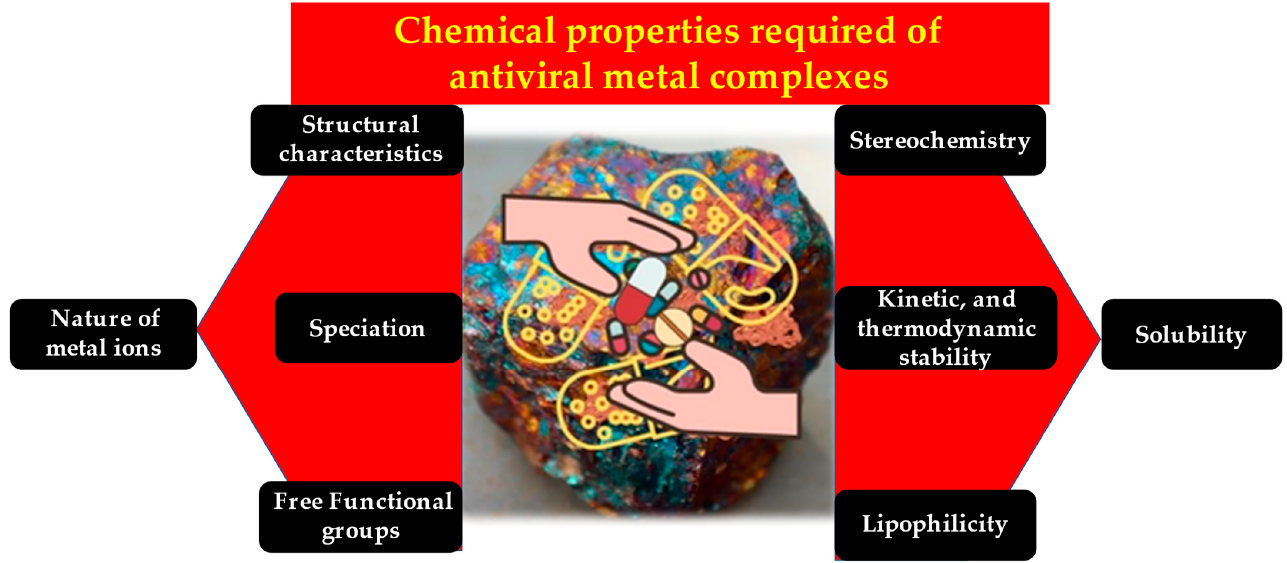
Figure 2. The unique chemical characteristics of metal complexes add up to their antiviral property.